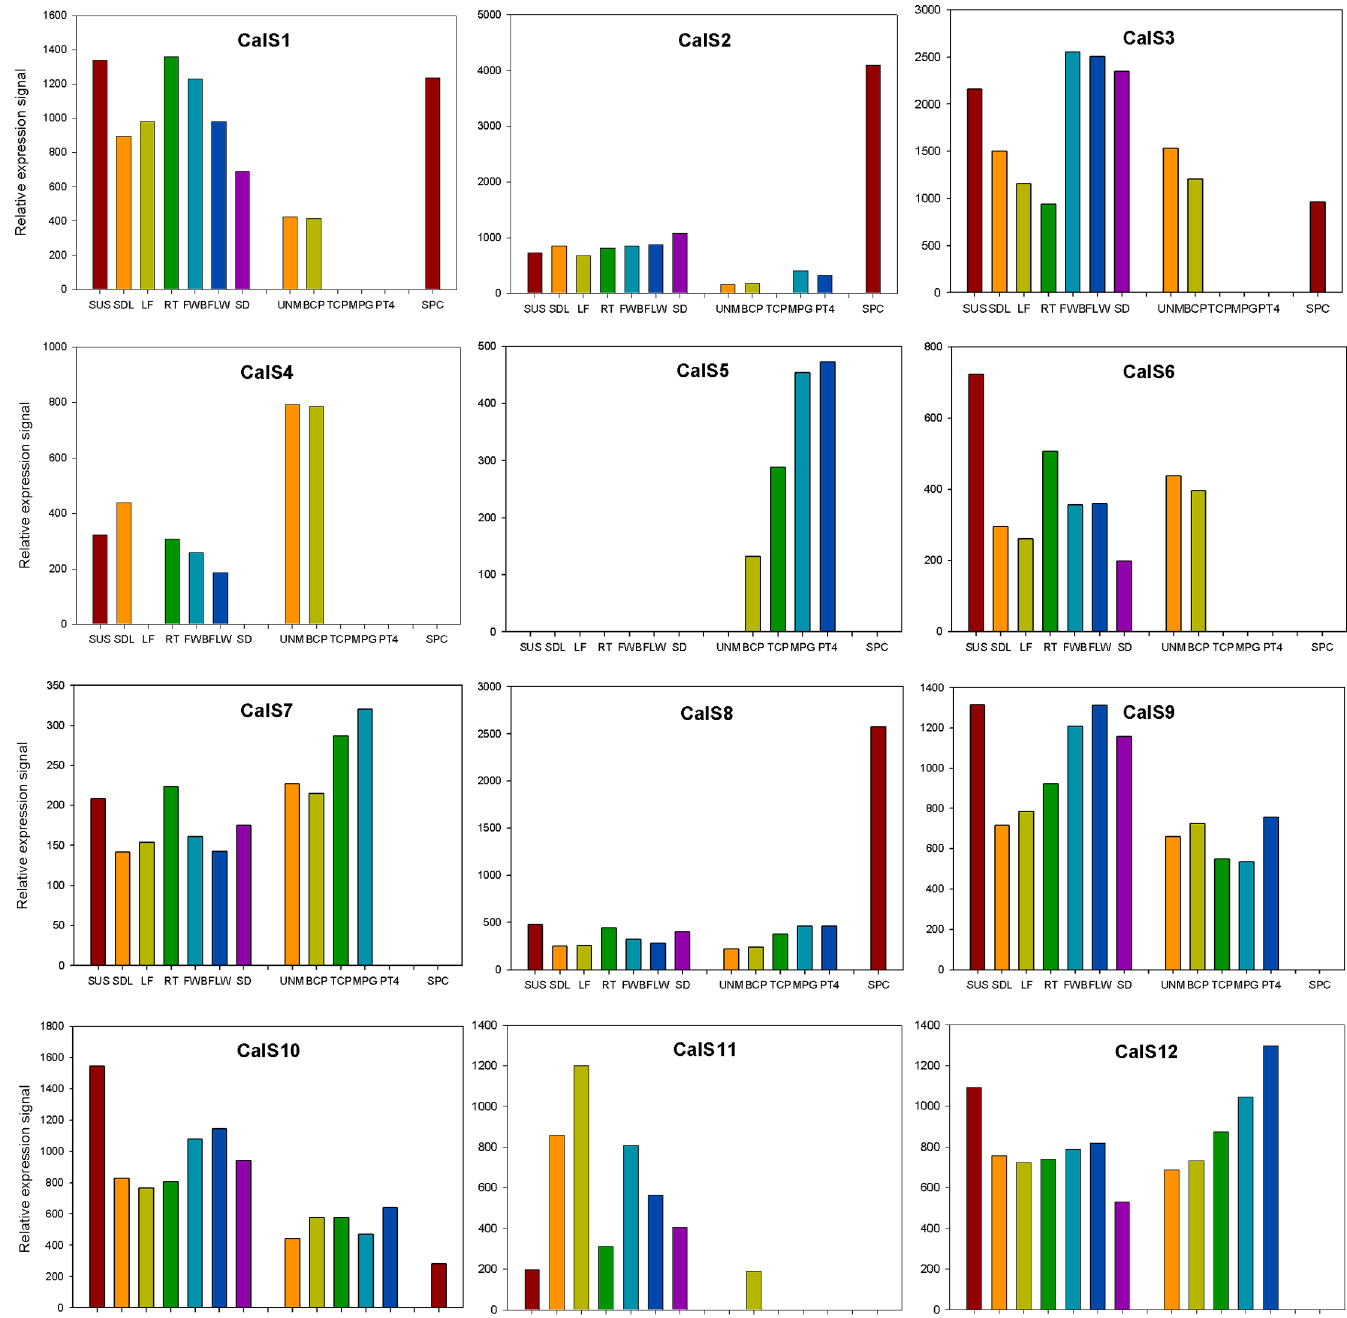
Fig 2. Expression profiles of 12 callose synthases in different sporophytic tissues and during male gametophyte development of Arabidopsis thaliana . SUS, suspensioncultures; SDL, seedling; LF, leaf; RT, root; FWB, flower buds; FLW, flower; SD, seed; UNM, uninuclear microspore; BCP, bicellularpollen; TCP, tricellularpollen; MPG, mature pollengrain; PT4, 4h pollentubes; SPC, sperm cells.